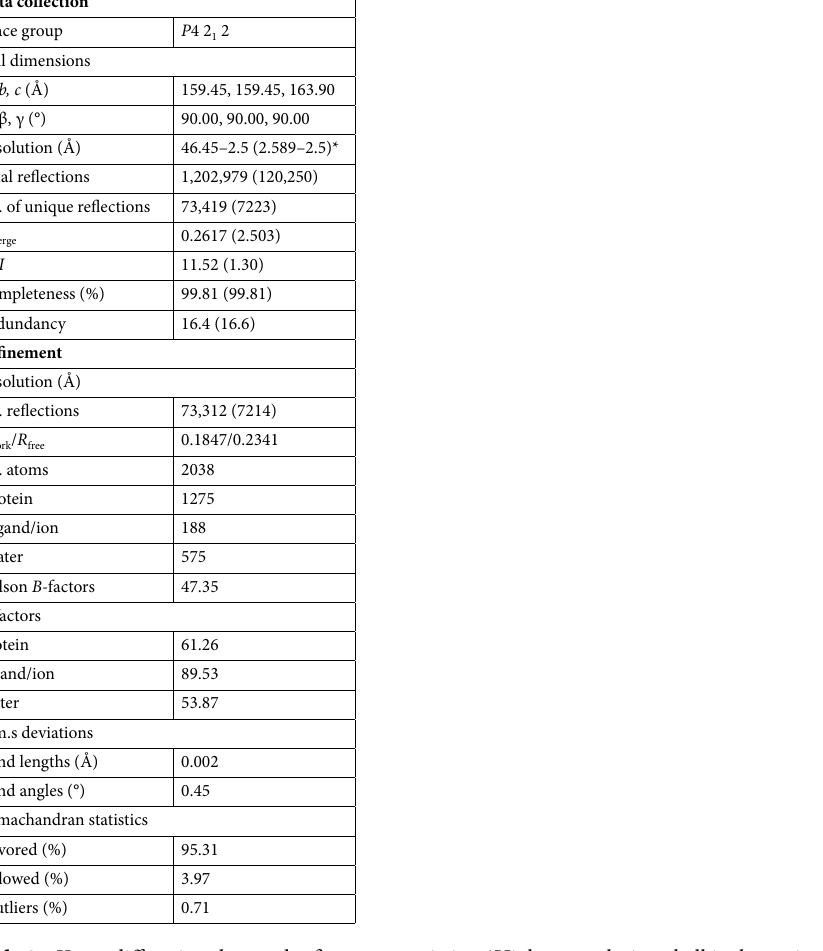
Table 2. X-ray diffraction data and refinement statistics. *Highest resolution shell is shown in